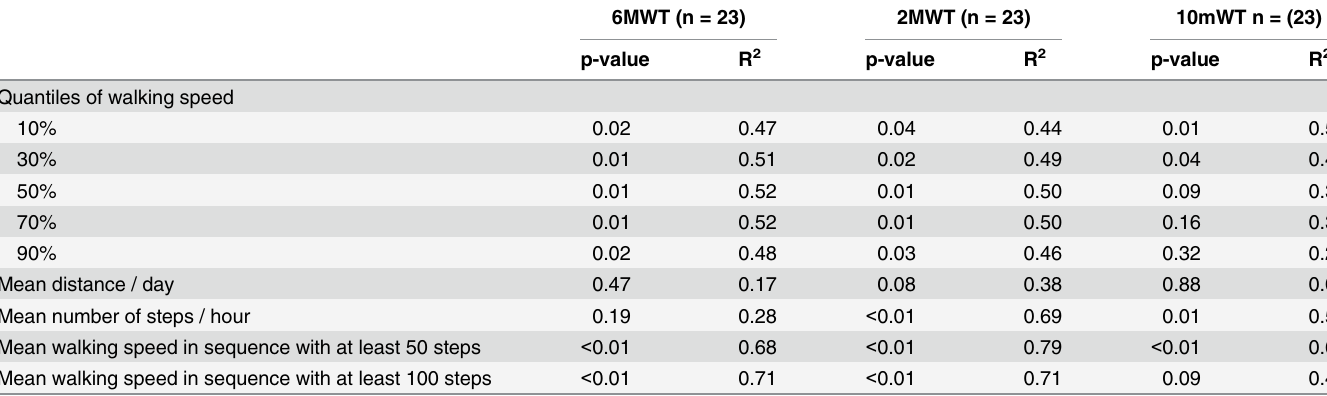
Table 3. Correlation between clinical gait test and daily life mobility